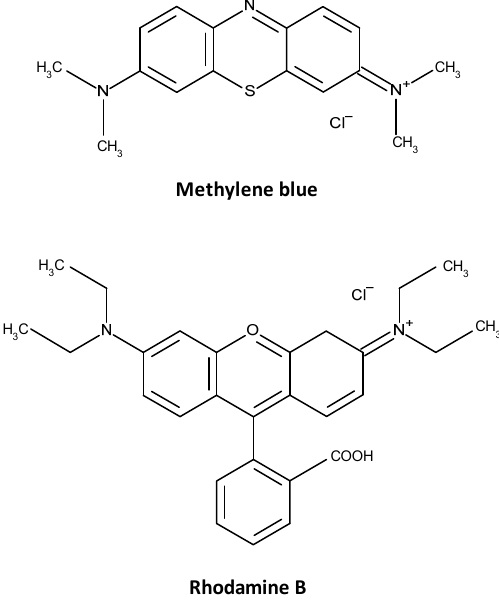
Figure 2. Molecular structures of methylene blue and rhodamine B.